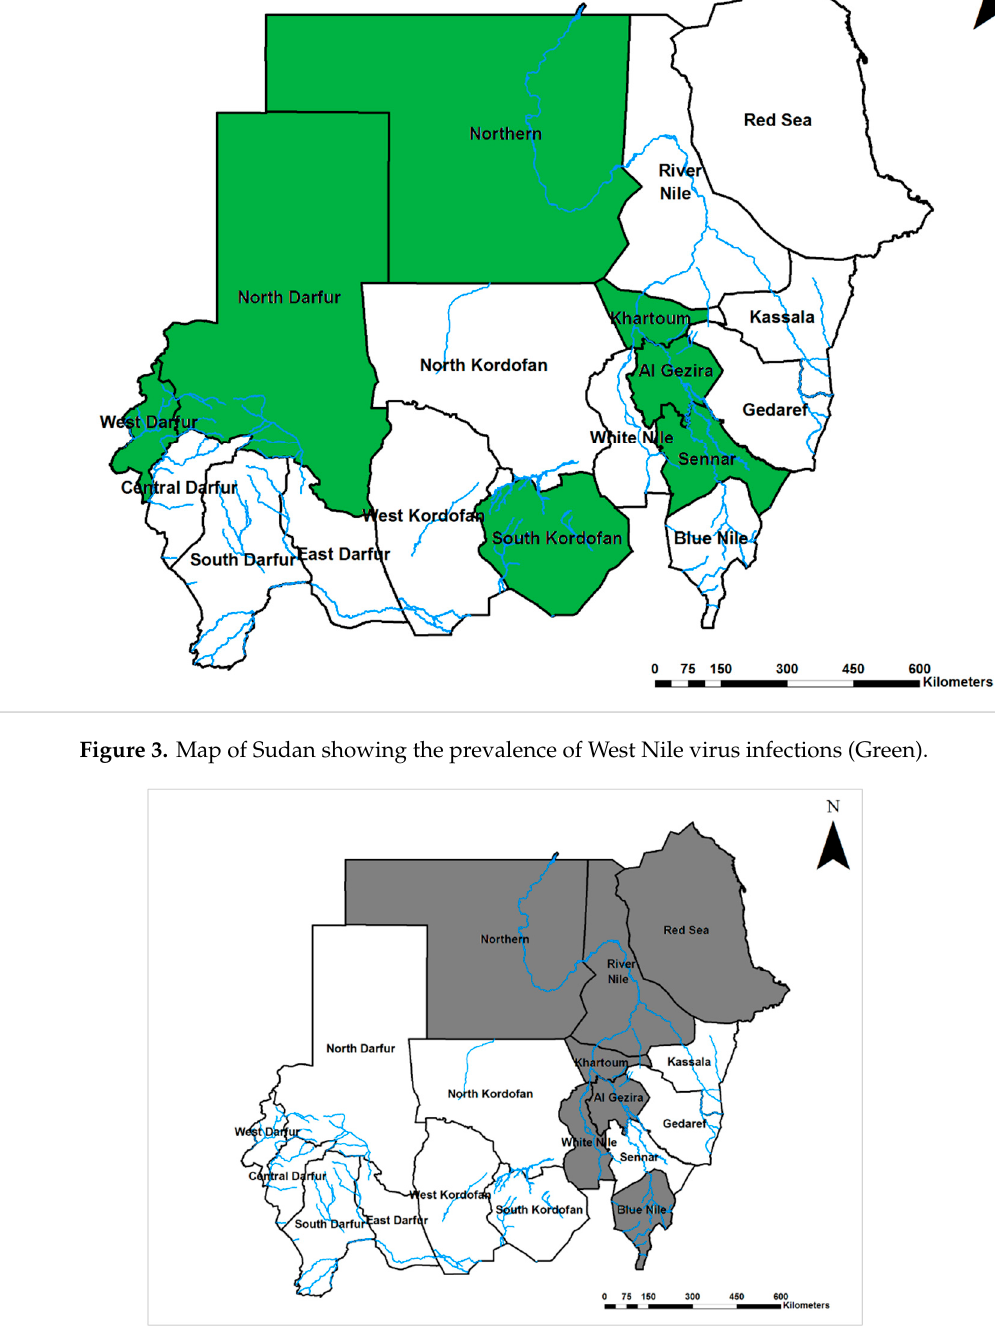
Figure 4. Map of Sudan showing the prevalence of Zika virus infections